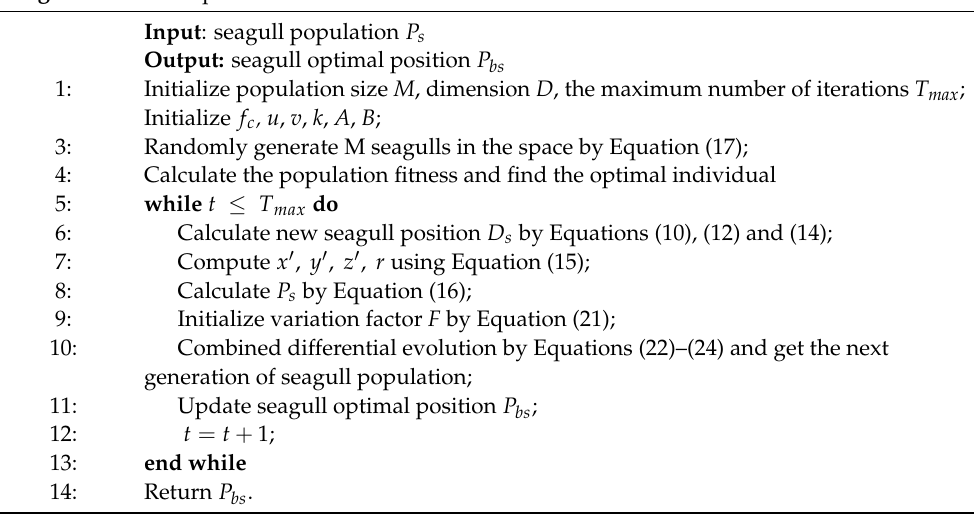
Algorithm 1 ISOA pseudo-code